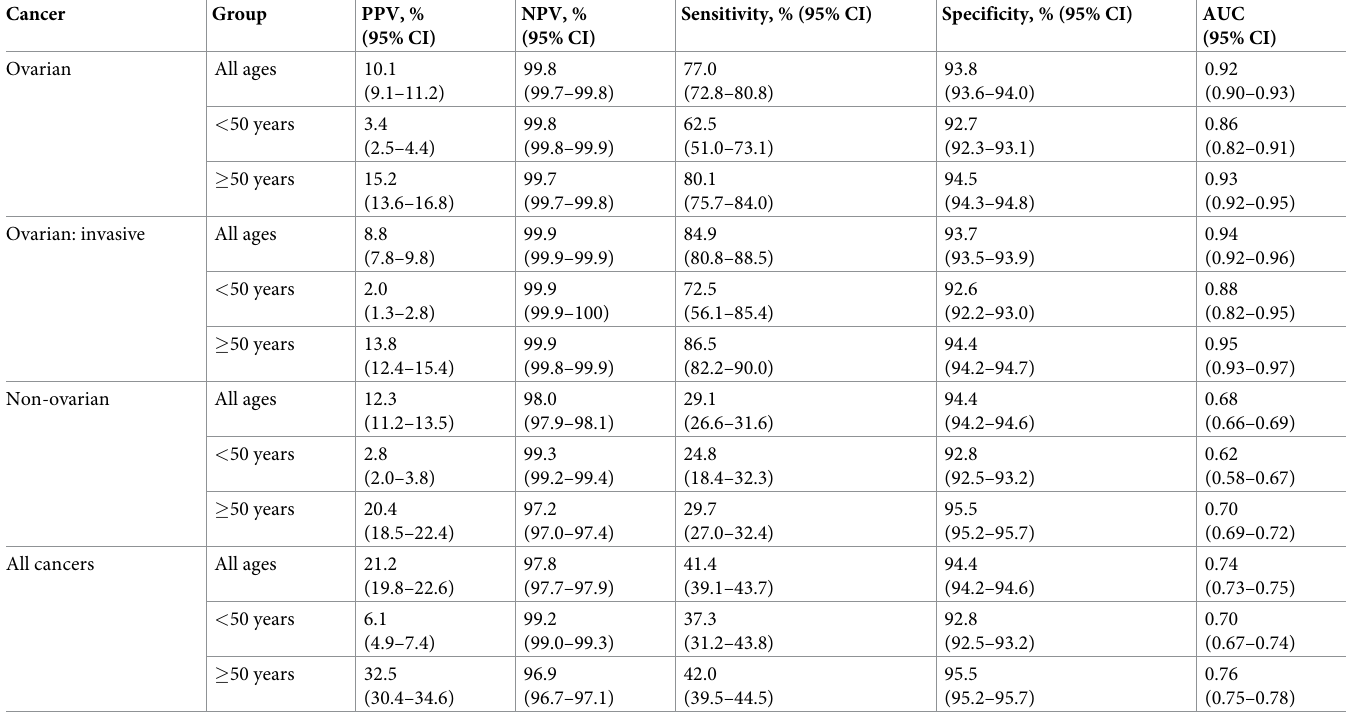
Table 3. Performance characteristics of CA125 for ovarian cancer, invasive ovarian cancer, non-ovarian cancers and all